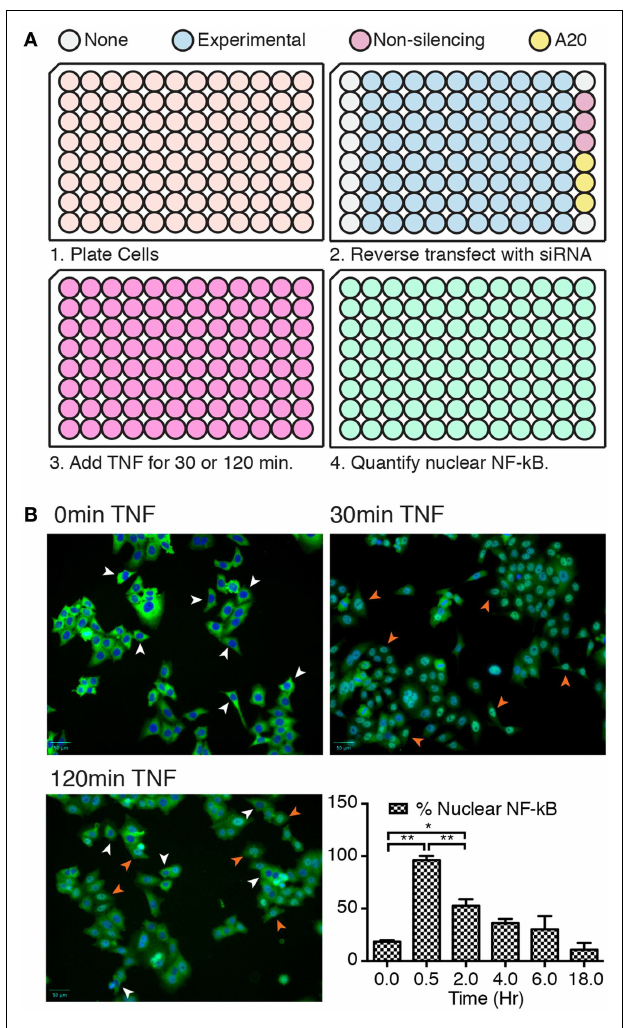
FIGURE 1 | (A) Overview of key steps in the high-content assay. Step 2 shows the organization of siRNA pools within each plate. (B) Representative images of cells treated withTNF for 0, 30, and 120min, and stained for NF- κ B (green) and nuclear DNA (blue). Representative cells with cytosolic NF- κ B are shown with white arrowheads and cells with nuclear NF- κ B are shown with orange arrowheads.The bar chart shows the percentage of cells with nuclear NF- κ B at the indicated times ofTNF exposure. Results are shown as the average of three independent measurements and error bars indicate standard deviations. Statistical analysis was performed with a one-way ANOVA analysis, and one and two asterisks indicate p values below 0.05 and 0.01,